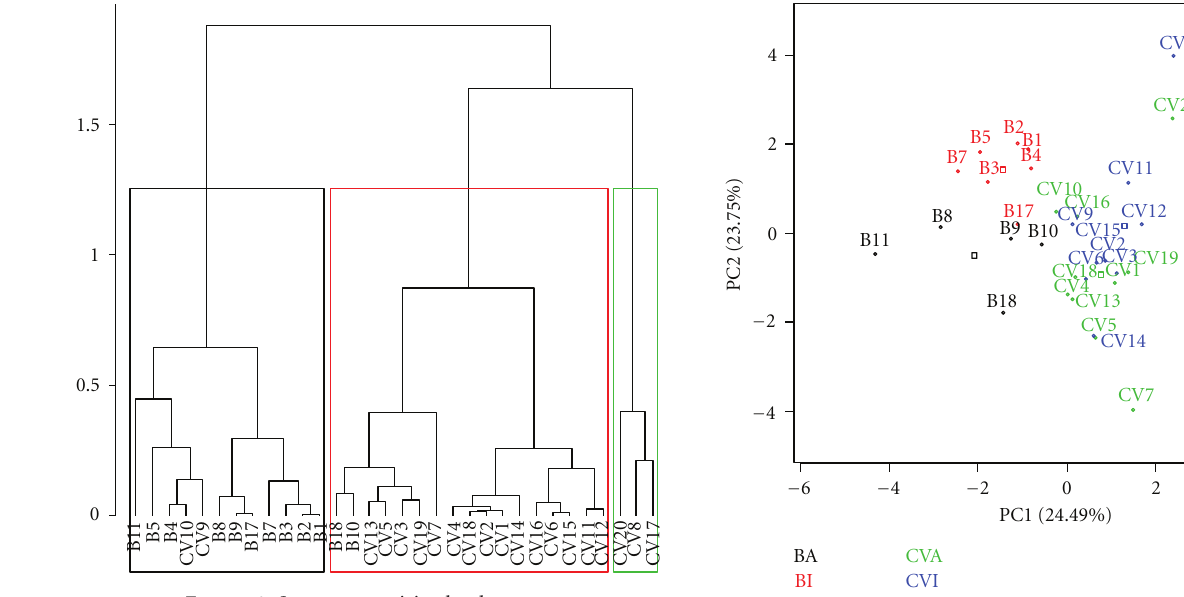
Figure 2: Sugar cane spirits dendrogram.